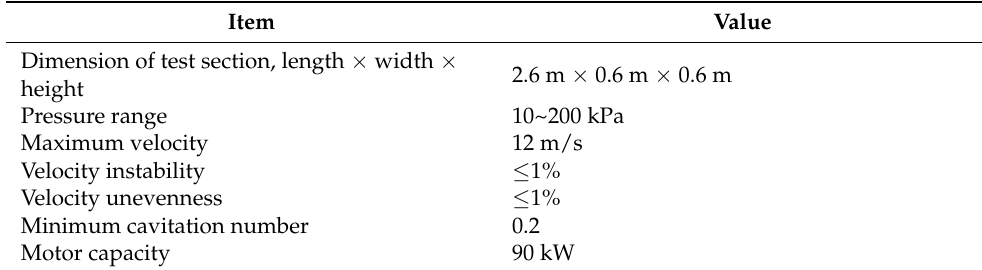
Table 1. Principal particulars of the cavitation tunnel.